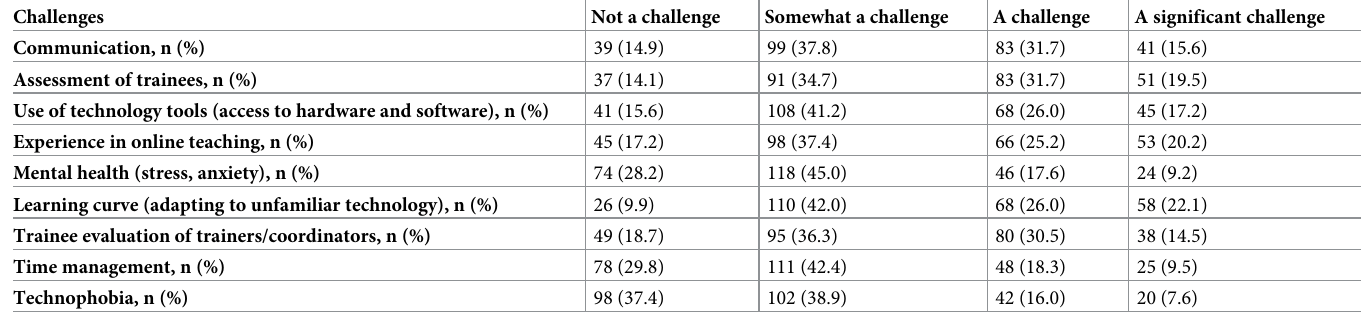
Table 2. Challenges to e-learning experienced by trainers and coordinators in the Saudi MOH during the COVID-19. Challenges Not a